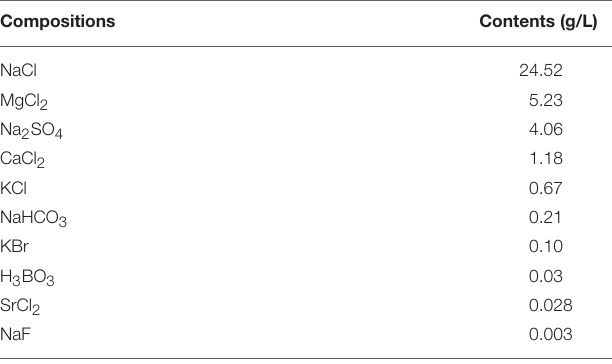
Frontiers in Materials |